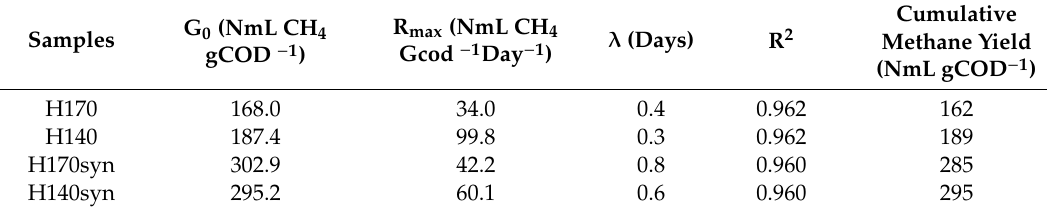
Figure 1. Cumulative methane yield of hydrolysate pretreated at 140 °C and 170 °C from AMPTS II fitted with modified Gompertz law.